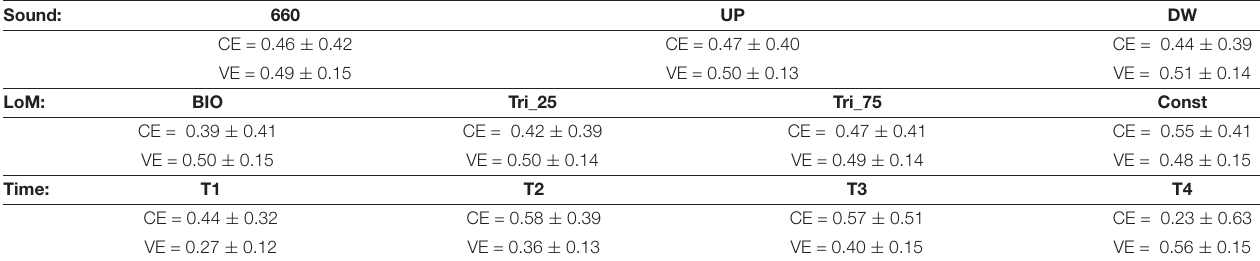
FIGURE 4 | Results of Experiment 2. (A) Constant Error (CE) for the three Sound conditions: constant frequency at 660 Hz, increasing pitch sound (UP), decreasing pitch sound (DW) (pitch envelopes are presented in Figure 2 and described in the text). (B) CE for the four Laws of Motion (LoM): Biologic velocity profile (BIO), Triangular velocity profile with a peak of velocity at 25% of the trajectory (Tri25), Triangular profile with a peak at 75% (Tri75), Constant velocity profile (Const). (C) Interaction between Sound and Time main factors. Each group of bars refers to a different Time condition (T1 = 0.5 s, T2 = 1.0 s, T3 = 1.5 s, T4 = 3.0 s); in each group, bars respectively presents the CE value of the three Sound conditions: 660, UP, DW (respectively black, dark-gray, and light-gray color). Sound characteristics and statistical significances are described in the text. (D) Interaction between LoM and Time main actors. For each Time conditions (T1 = 0.5 s, T2 = 1.0, T3 = 1.5, T4 = 3.0) bars represent the CE of the LoM conditions (from the black to the light-gray bar, respectively: BIO, Tri25, Tri75, Const). Statistical significances are described in the text. For all charts: Y -values are in seconds, error bars represent standard errors of the mean, and stars indicate significant statistical differences (when the star is in the headline, please refer to the text for details regarding the statistical differences between conditions). TABLE 2 | Results of Experiment 2 – Constant Error (CE) and Variable Error (VE) for the three main factors: Sound, Time, and Law of Motion